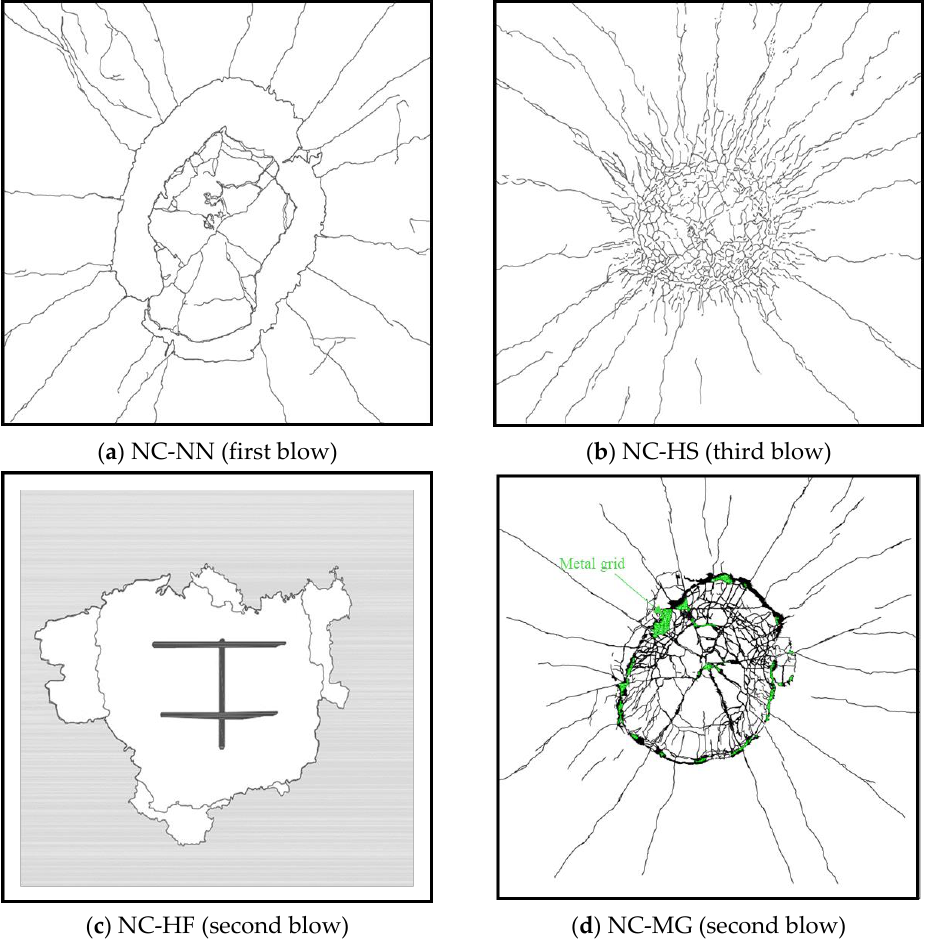
Figure 11. Crack distribution and failure mode.